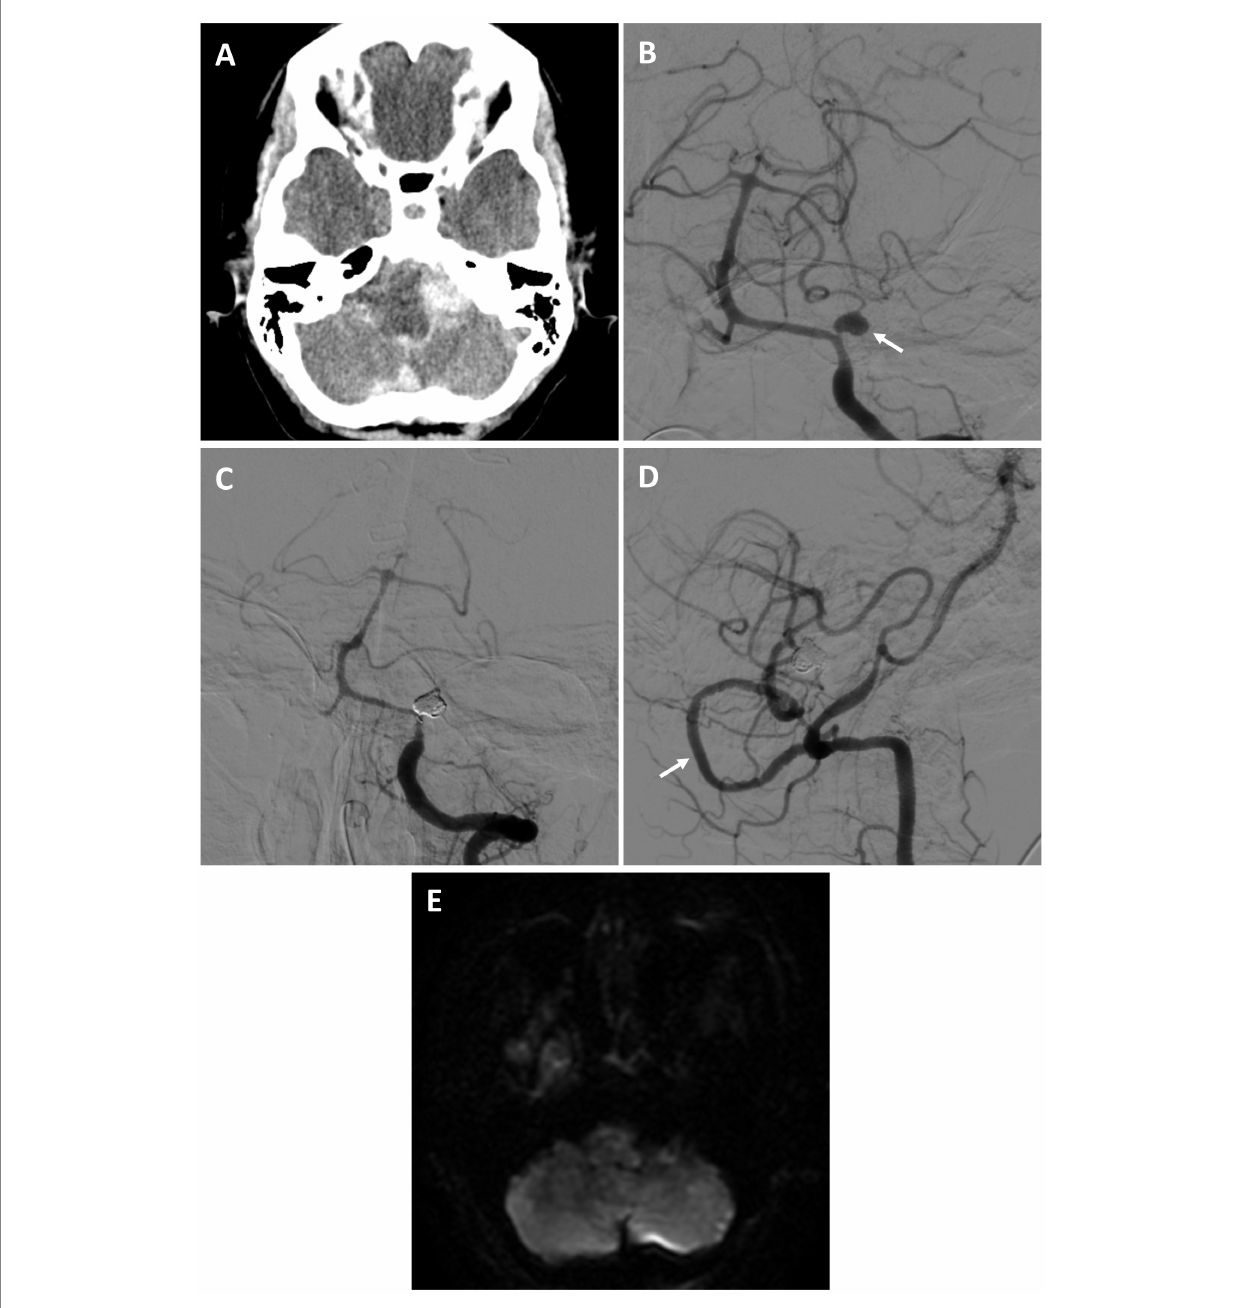
FIGURE 2 Patient #7. A 59-year-old female experienced a Hunt and Hess 3, Fisher 4 SAH from a left proximal PICA fusiform aneurysm [ (A) axial non-contrast head CT; (B) AP angiogram of the left vertebral artery (arrow highlighting aneurysm)]. She underwent a V3 to PICA bypass using a DLCFA interposition graft, followed by internal PICA aneurysm embolization. She had no strokes and an uneventful recovery. On 4-month follow was performing all activities of daily living independently. Angiogram demonstrating PICA occlusion [ (C) AP left vertebral artery injection, and patent bypass (D) lateral right vertebral artery injection (arrow highlights bypass)]. (E) Post-procedural MRI (axial DWI) demonstrated no